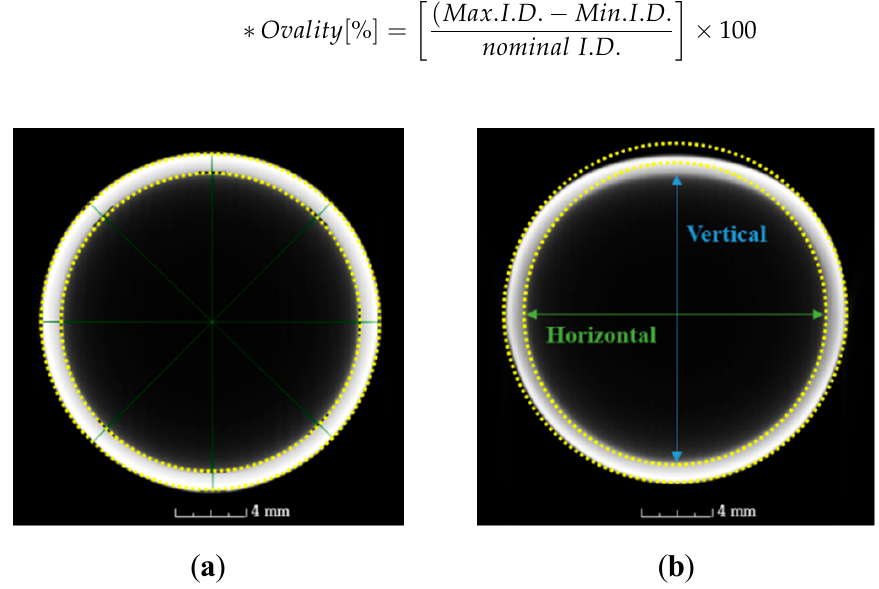
Figure 3. The cross-sectional areas from the CT analysis for the: ( a ) straight tube and ( b ) U-bend tube.